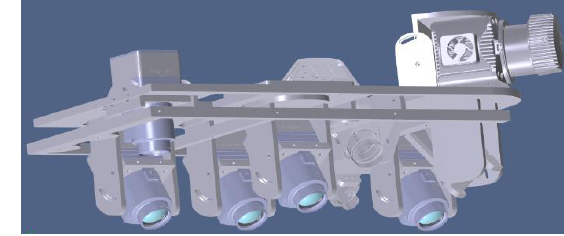
Figure 1. Rendered CAD model of the mountings